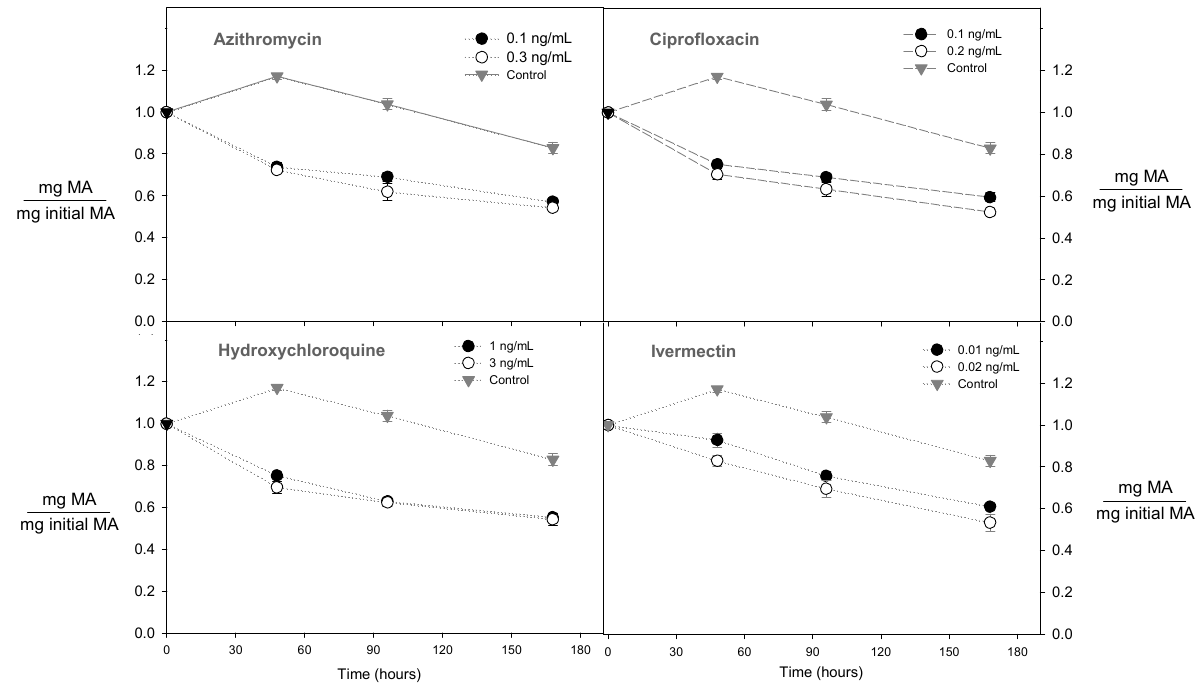
Figure 3. Effect of antibiotic type on total monomeric anthocyanins during the fermentation process.